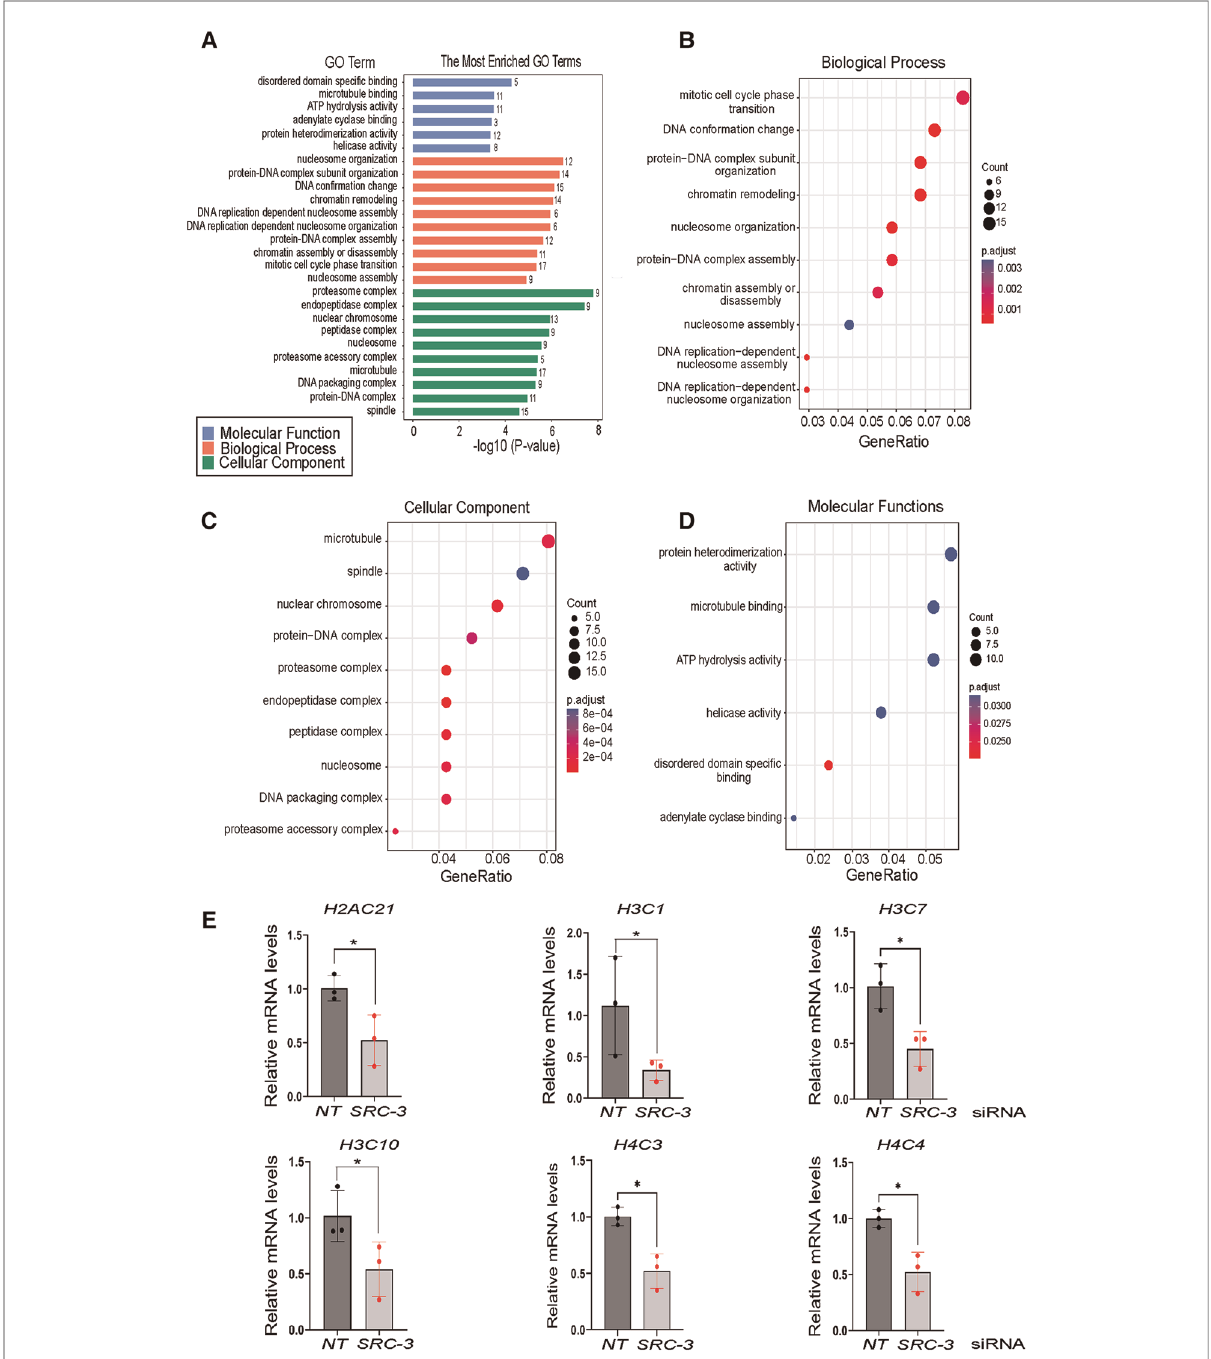
FIGURE 6 Gene ontology functional analyses of differentially expressed genes in T-HESCs following SRC-3 knockdown ( A ) gene ontology (GO) enrichment analysis of differentially expressed genes was achieved using the DAVID. The six signi fi cantly enriched GO terms ( p <0.05) in molecular function along with the ten top signi fi cantly enriched GO terms in biological processes and cellular component branches are presented. The adjusted p - values of the terms were – log10 transformed. ( B – D ) Dot plots of enriched genes within the differentially expressed gene set are strati fi ed according to biological processes, cellular components, and molecular functions respectively. ( E ) Quantitative real time PCR analysis shows signi fi cant reduction in the induction of the following histone family members: H2AC21 , H3C1 , H3C7 , H3C10 , H4C3 , and H4C4 in T-HESCs following SRC-3